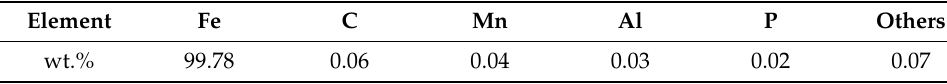
Table 1. Composition of Fe waste powder (wt.%).